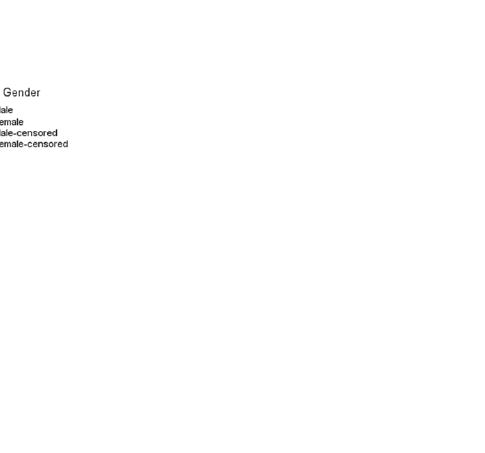
Fig 5. Kaplan-Meier cumulative survivorship of MAT in the cartilage Outerbridge grade < III group — gender: no statistically significant difference between males (blue line) and females (green line) (p = 0.901).